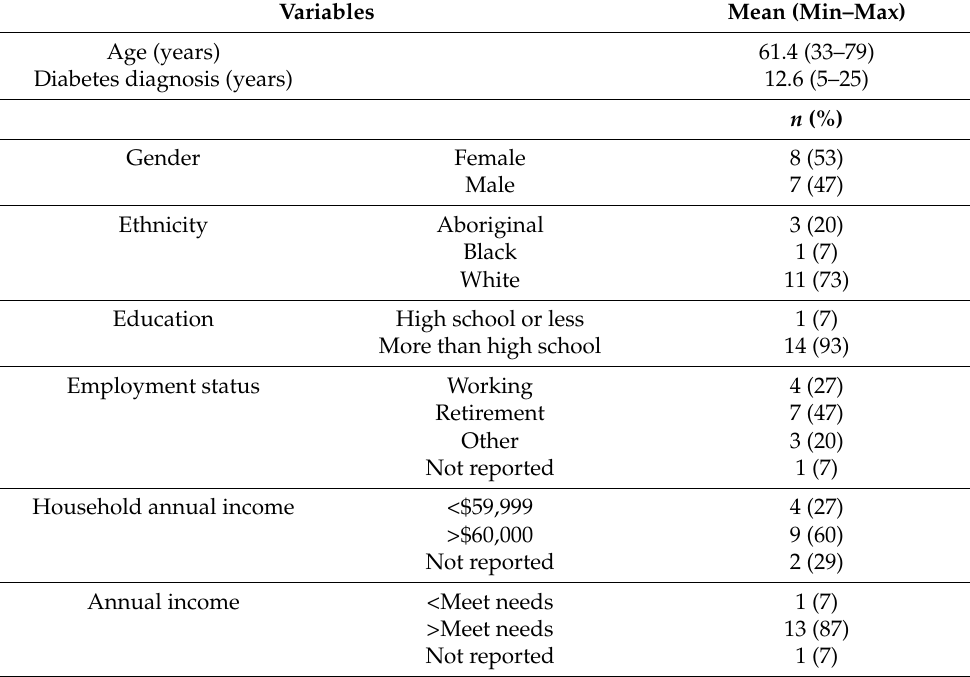
Table 1. Demographic characteristics of